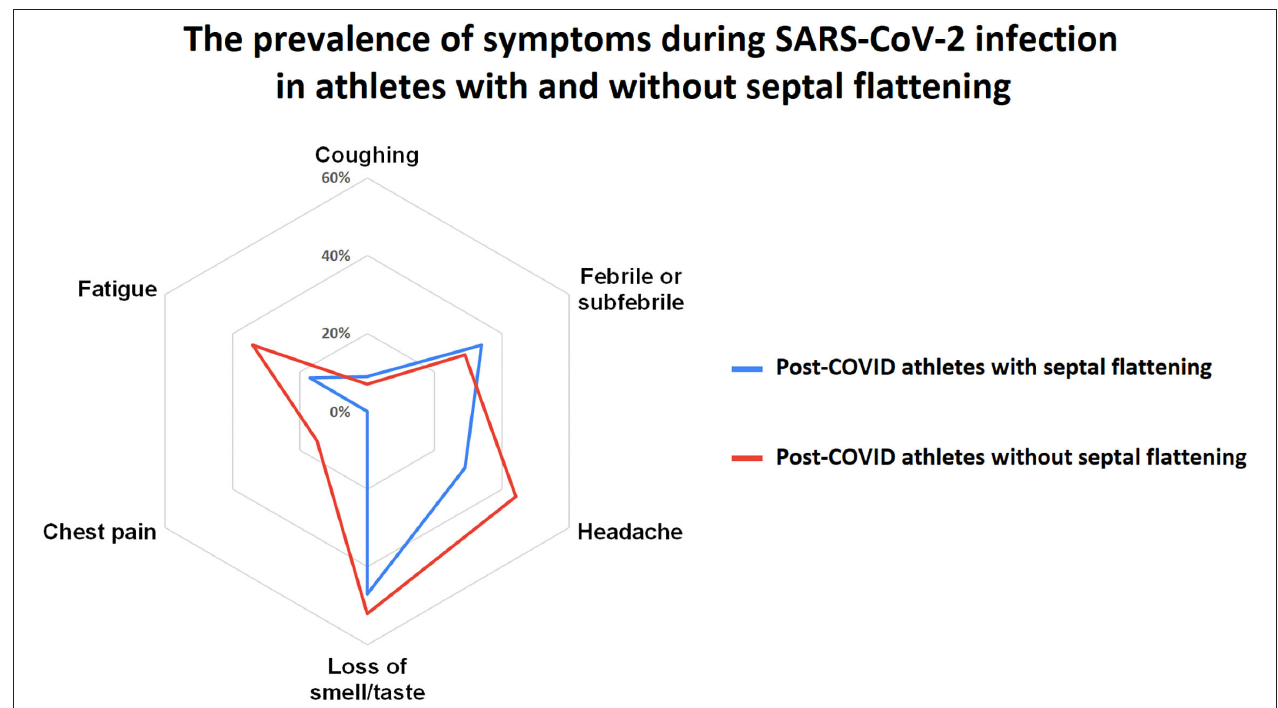
FIGURE 2 | Radar chart comparisons of the most relevant symptoms in post-COVID athletes with our without septal flattening (SF). Athletes with SF (blue line) and without SF (red line) did not differ in the incidence of fever or subfebrility, coughing, headache or the lost of smell and/or taste. On the other hand, chest pain and fatigue were significantly more frequent in athletes without SF. In general, athletes with SF were less symptomatic, as shown by the smaller area of the radar chart compared to athletes without SF (see details in text).